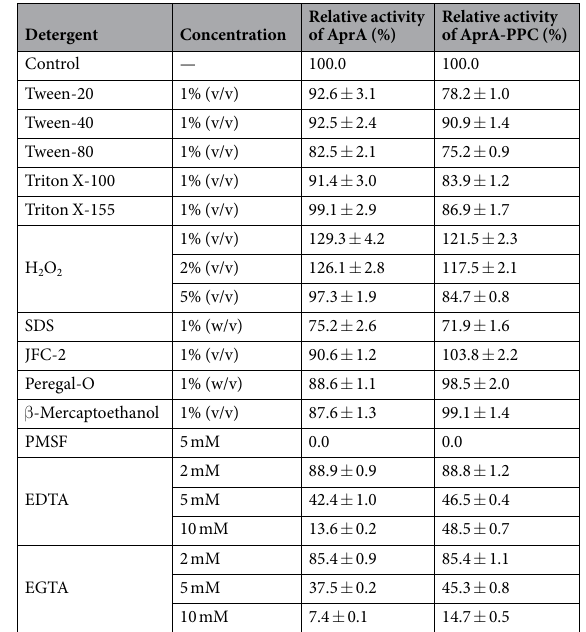
Table 3. Effect of detergents, oxidizing and reducing reagents and protease inhibitors on enzyme activity.